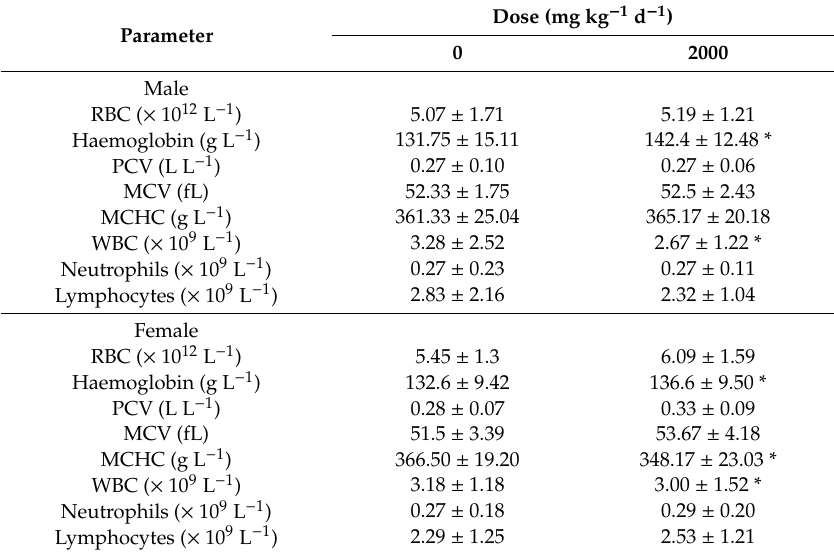
RBC: red blood cell count, MCV: mean corpuscular volume, MCH: mean corpuscular haemoglobin, MCHC: mean corpuscular haemoglobin concentration, WBC: white blood cell count, PCV: packed cell